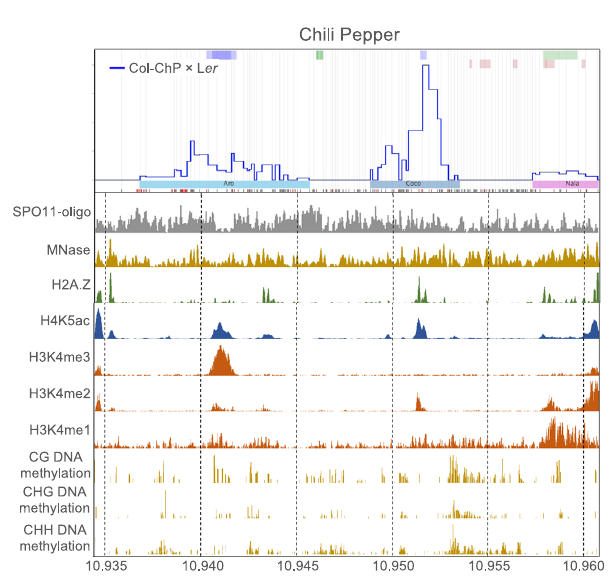
Fig.2|ChromatinlandscapeintheChPinterval. Histogramsshowingnormalized coverage values for SPO11-1-oligonucleotides 85 , nucleosome occupancy (MNase- seq) 86 , H2A.Z 86 , H4K5ac 78 , H3K4me1/me3 87 , H3K4me2 88 , and DNA methylation (BSseq) in CG, CHG, and CHH sequence contexts 89 were presented in relation